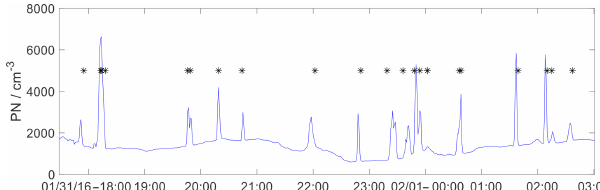
Figure 5. Particle number concentration measured with a CPC, and calculated incidents of ship plume passages (stars) determined with AIS and meteorological data, versus time (31 January–1 Febru- ary 2016), from measurements at the coastline in southern Sweden during an episode with westerly winds blowing from the Øresund strait to the coastal station Falsterbo. The concentrations are those of the total aerosol; i.e. background concentrations are not